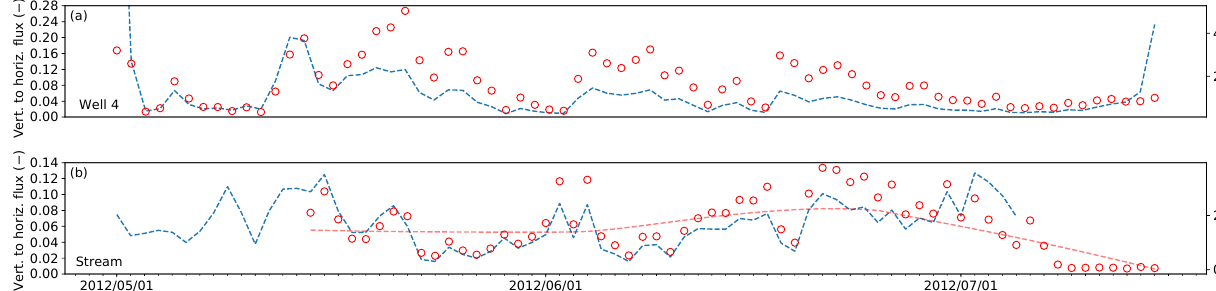
Figure 7. Blue dashed line, left axis: estimation of the contribution of diurnal (vertical) fluxes to lateral (horizontal) fluxes at well 4 (a) and stream (b) ; red circles, right axis: amplitude of diurnal pressure head fluctuations for well 4 (a) and stream (b) . The dashed red line in Fig. 8b is the lowess fit of diurnal amplitudes in the well.